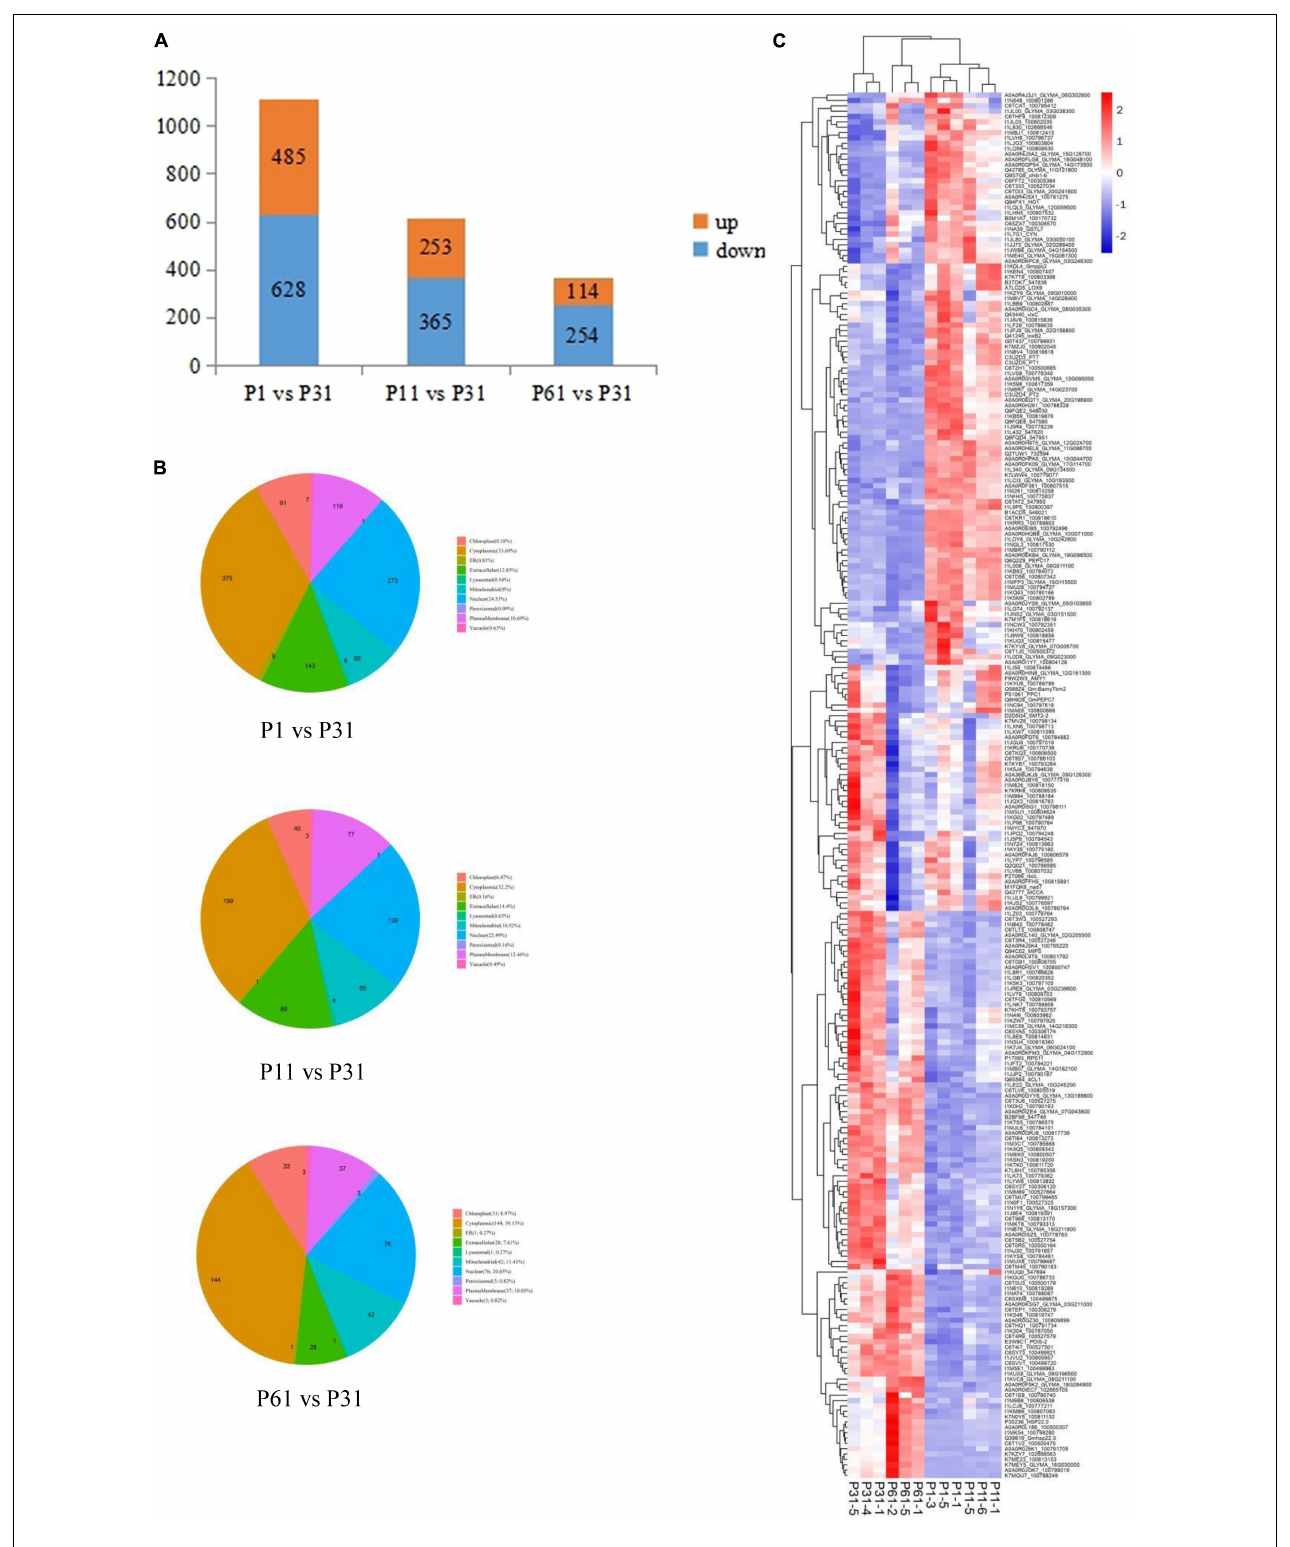
FIGURE 1 | Analysis of the DEPs. (A) Number of DEPs, up-regulated and down- regulated expression between P1 vs. P31, P11 vs. P31, P61 vs. P31; (B) Pie chart for subcellular localization analysis of DEPs; (C) Heatmap clustering analysis of DEPs. The color blocks at different positions represent the relative expression levels of the proteins at the corresponding positions, red represents the high expression level, and blue represents the low expression level.